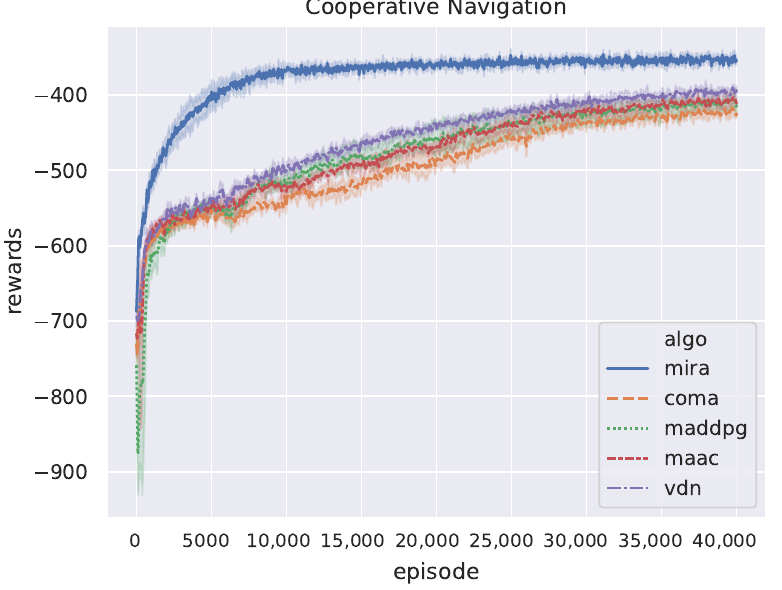
Figure 5. The performance of MIRA and four CTDE baselines on the Cooperative Navigation benchmark. Table 3. Convergence performance of evaluated algorithms on Cooperative Navigation.